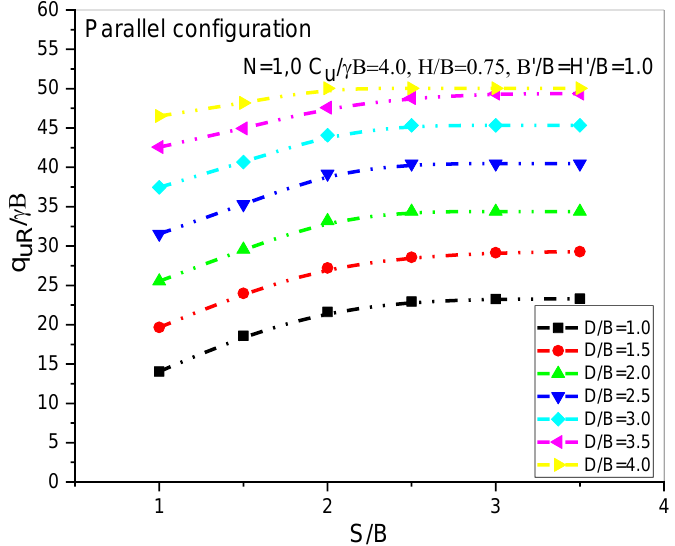
Figure 19. Effect of reinforcement on the ultimate bearing capacity ratio with a change in the parallel configuration of the two voids.